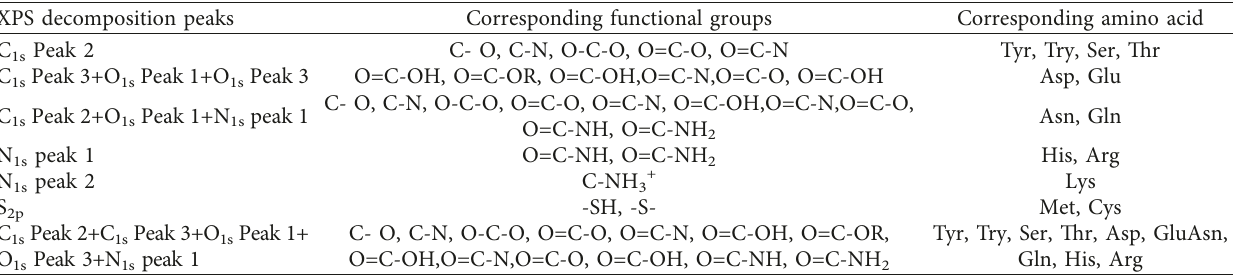
Table 5: The corresponding relationship between XPS decomposition peaks and the amino acids with side-chains containing corresponding functional groups. XPS decomposition